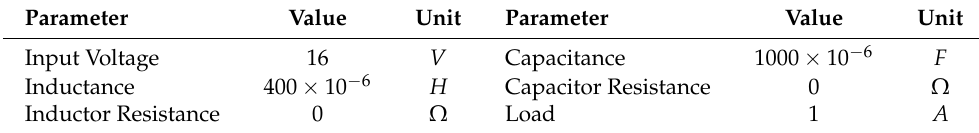
Table 2. Nominal system parameters of the studied EHSS for control system design. Parameter Value Unit